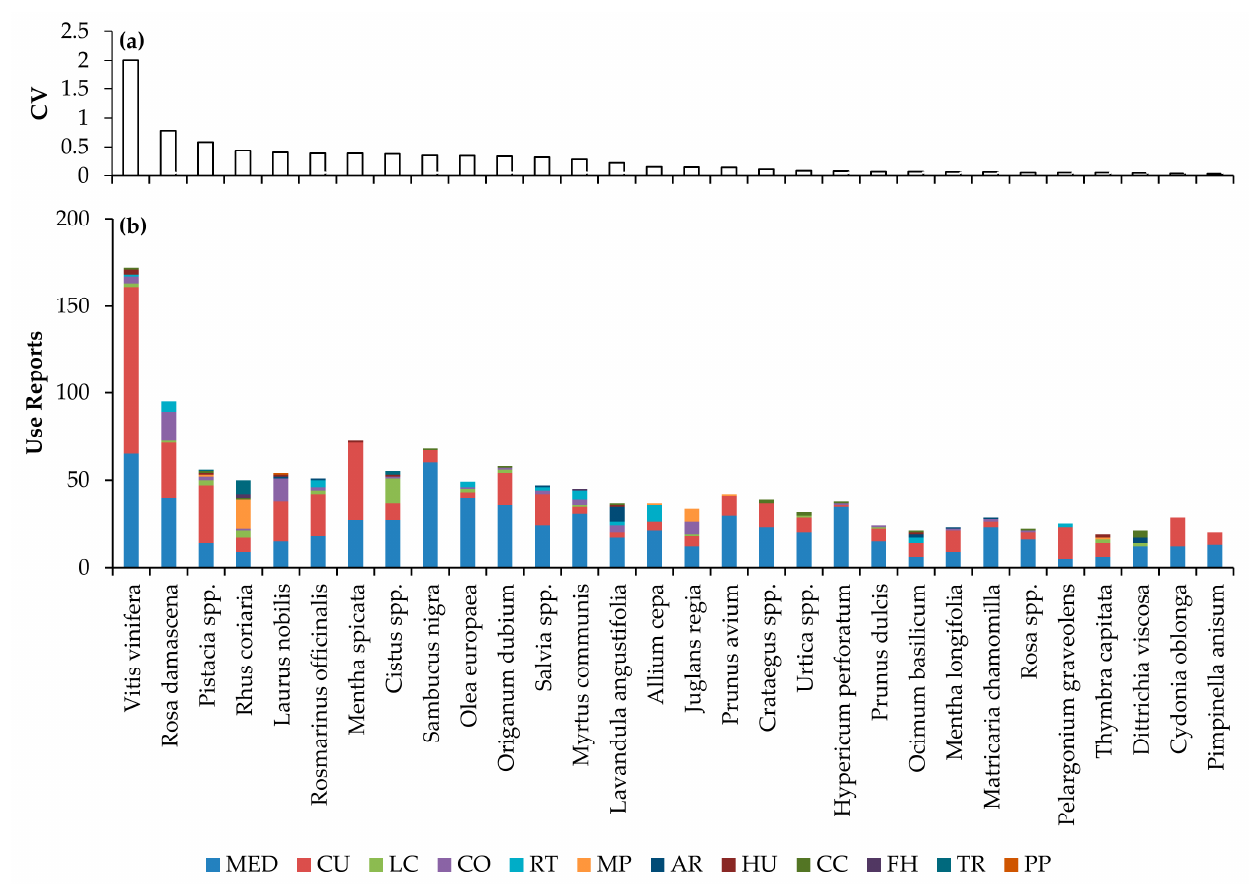
Figure 6. ( a ) The cultural value (CV), considering all uses, of the 30 more culturally significant taxa. ( b ) The number of use reports per taxa (bars) per use category (different colors per bar). Use categories: medicinal (MED), culinary (CU), livestock care (LC), cosmetics (CO), manufacture–processing (MP), religious traditions (RT), animal repellent (AR), crop care (CC), household use (HU), fishing–hunting (FH), trade (TR), poisonous plants (PP).